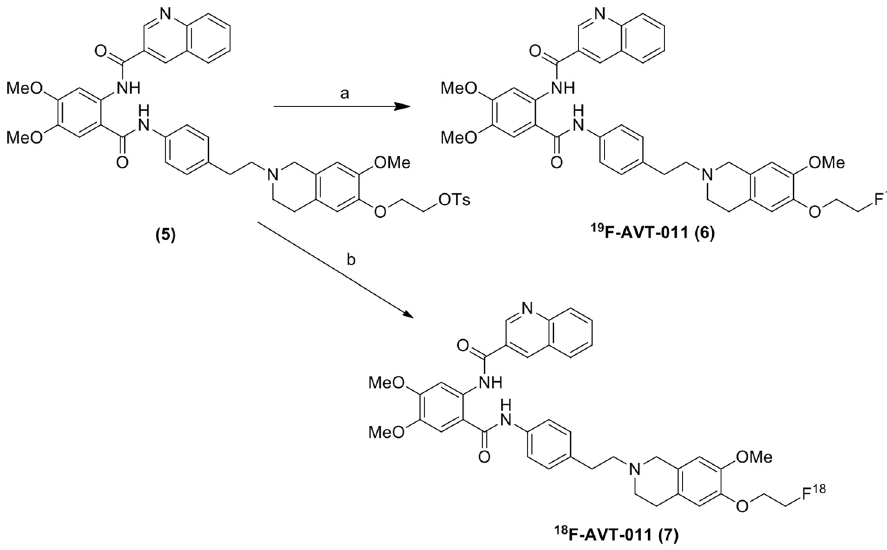
Figure 2. Reaction and reagents for the synthesis of the [ 18 F]AVT-011 ( 7 ): ( a ) NaF, Kryptofix